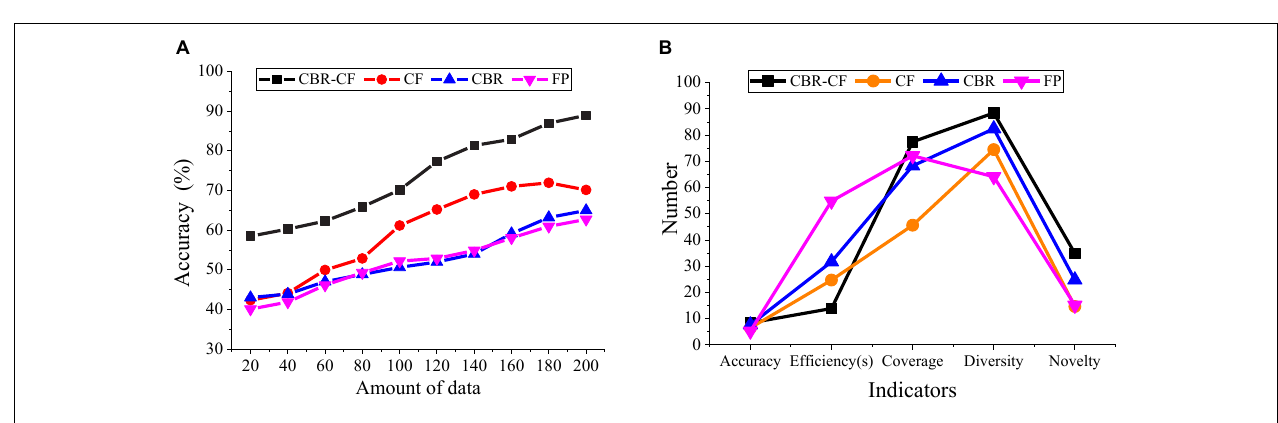
FIGURE 11 | Comparison and analysis of the accuracy and recall of different recommendation systems. (A) Comparison analysis of accuracy rate of different recommendation systems. (B) Comparison analysis of recall of different recommendation systems.